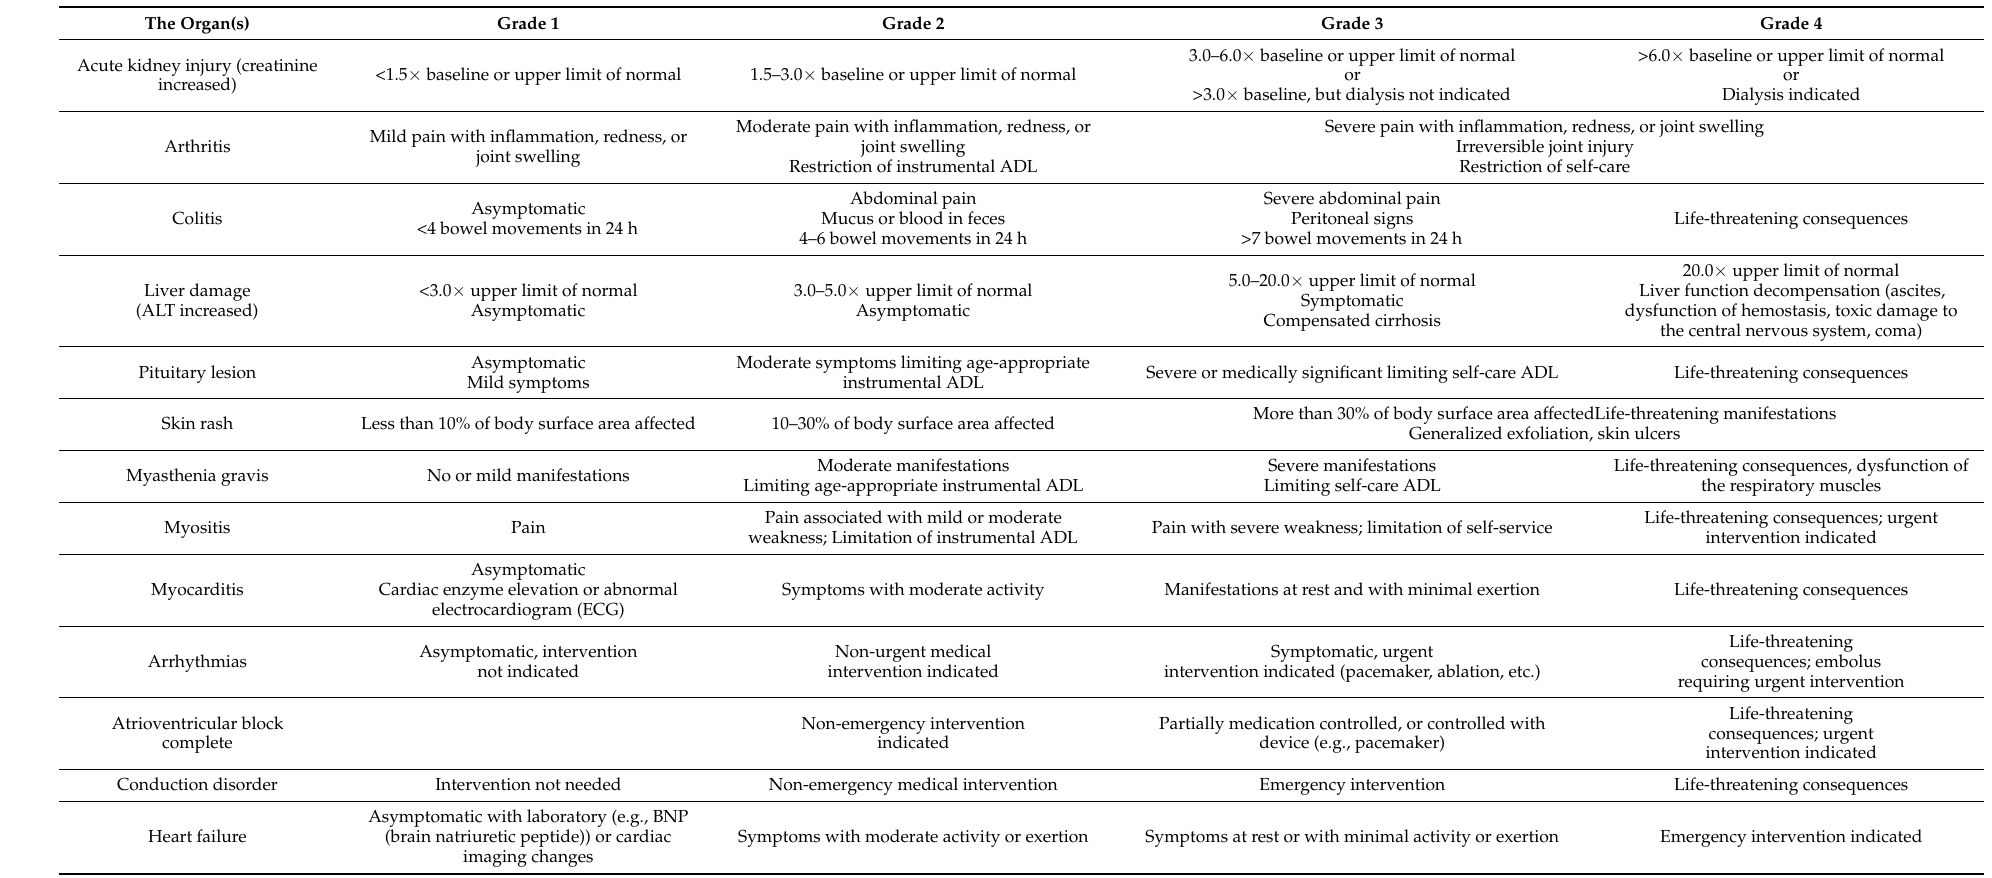
Table 2. IrAE grading